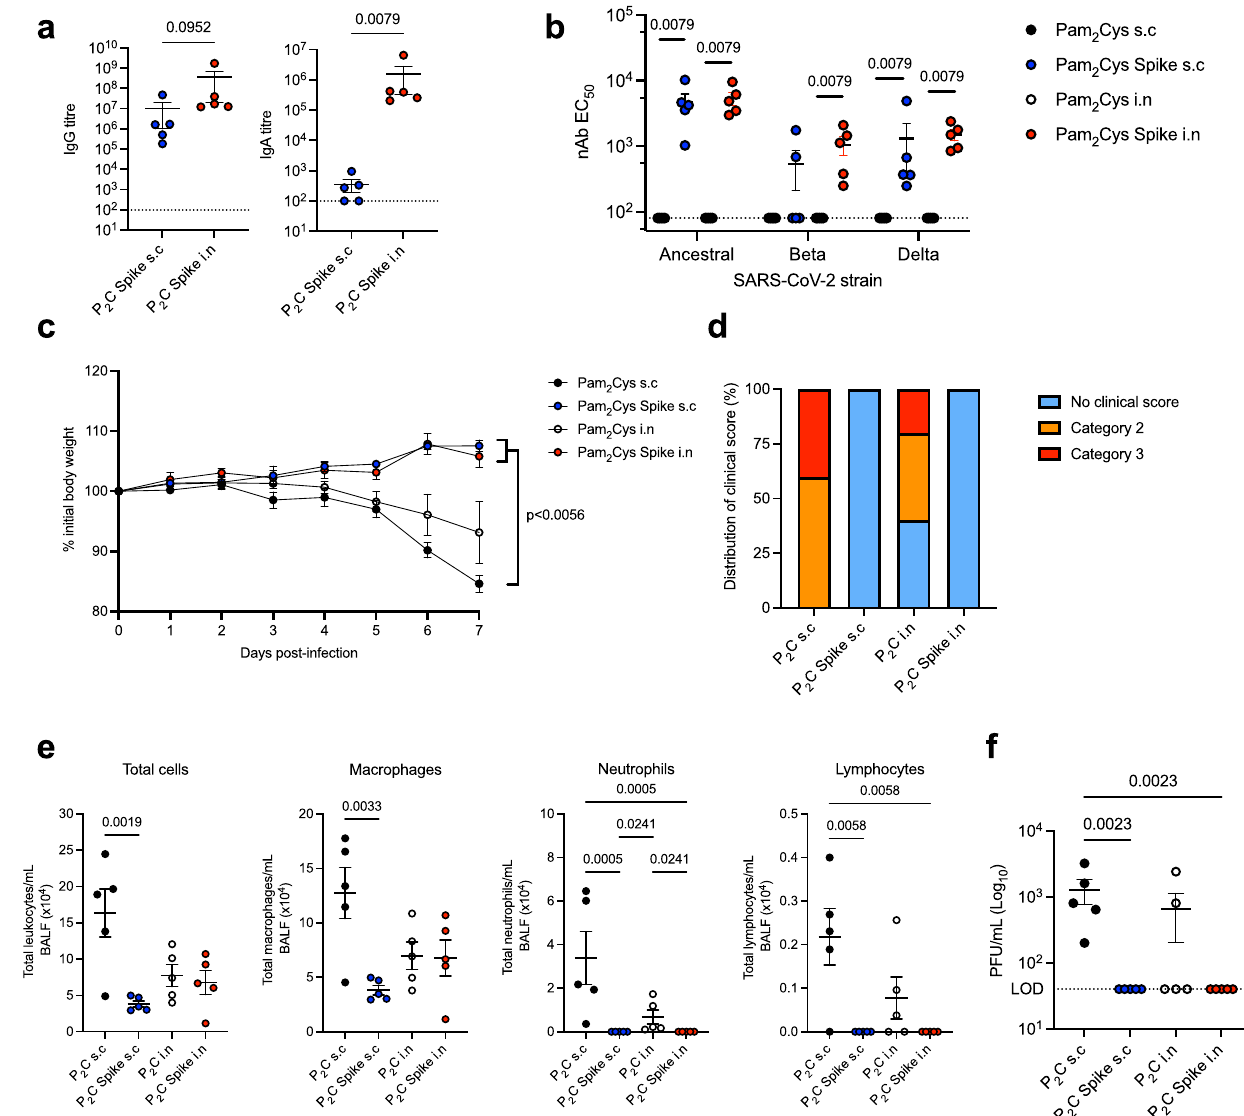
Fig. 8 | Vaccination with Pam 2 Cys Spike induces potent protection against SARS-CoV-2 challenge. K18-hACE2 mice ( n =5) were immunized with Pam 2 Cys alone (P 2 C; black), or Pam 2 Cys Spike, sub-cutaneously (s.c; blue) or intra-nasally (i.n;red)threetimes,twoweeksapart.Threeweekspost fi nalvaccinationmicewere challenged with 10 3 plaque forming units (PFU) of SARS-CoV-2 i.n and protective ef fi cacyassessed. a Anti-SpikeIgGandIgAtitres(log 10 scale)inserumcollectedone week post fi nal vaccination, determined by ELISA, and b neutralizing antibody (nAb) titres (log 10 scale) were determined as the titre needed for 50% inhibition of SARS-CoV-2 infection (ancestral, Beta or Delta variant) in HEK293-ACE2-TMPRSS2